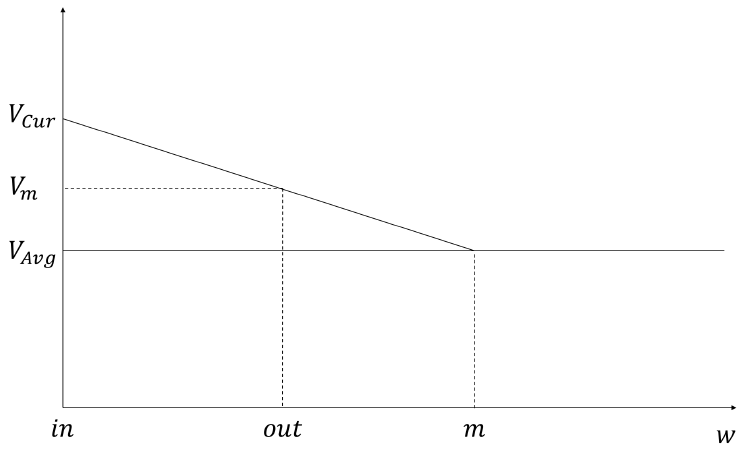
Figure A3. The location of m when a is small.